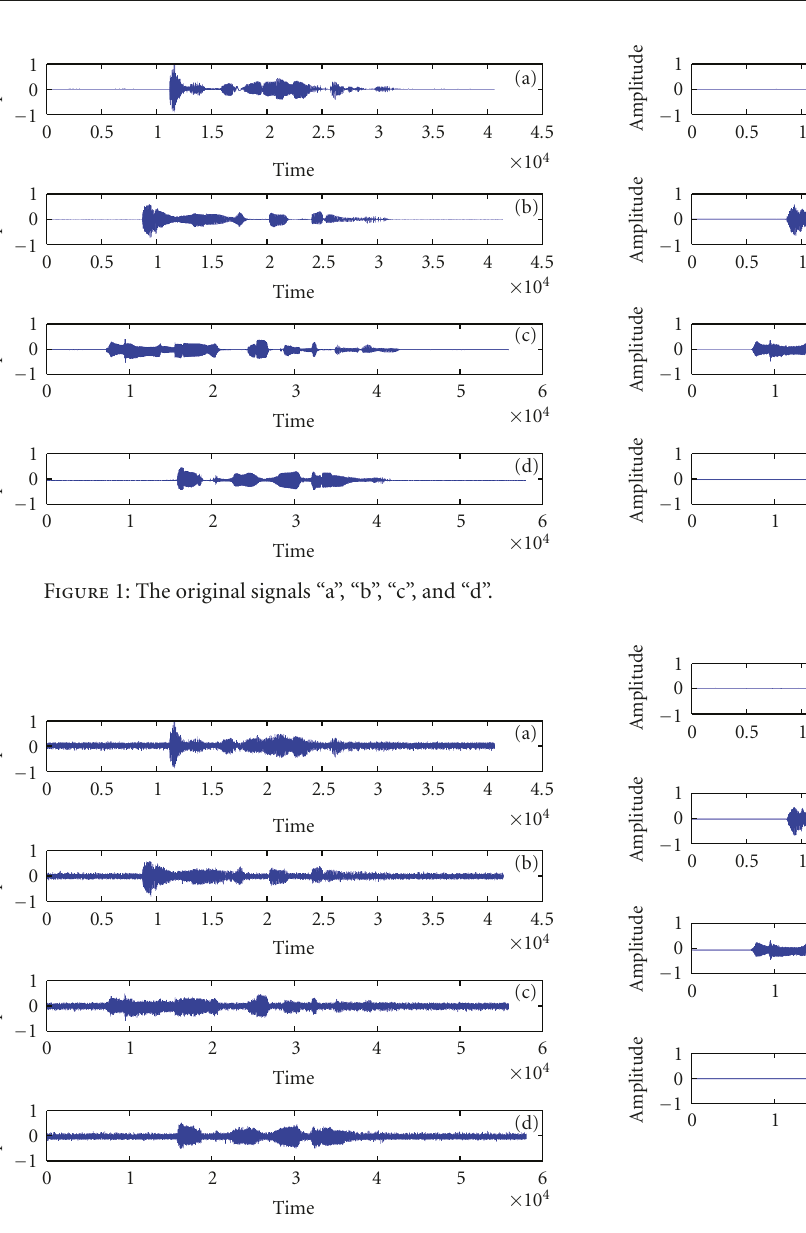
Figure 3: Denoising results of signals “a”, “b”, “c”, and “d” by the EMD-MMSE and the MMSE